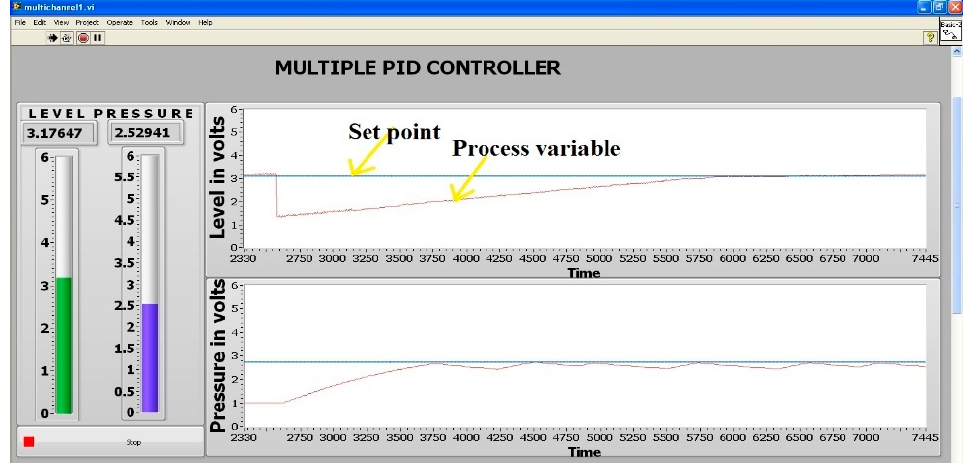
Figure 10. Data acquisition using